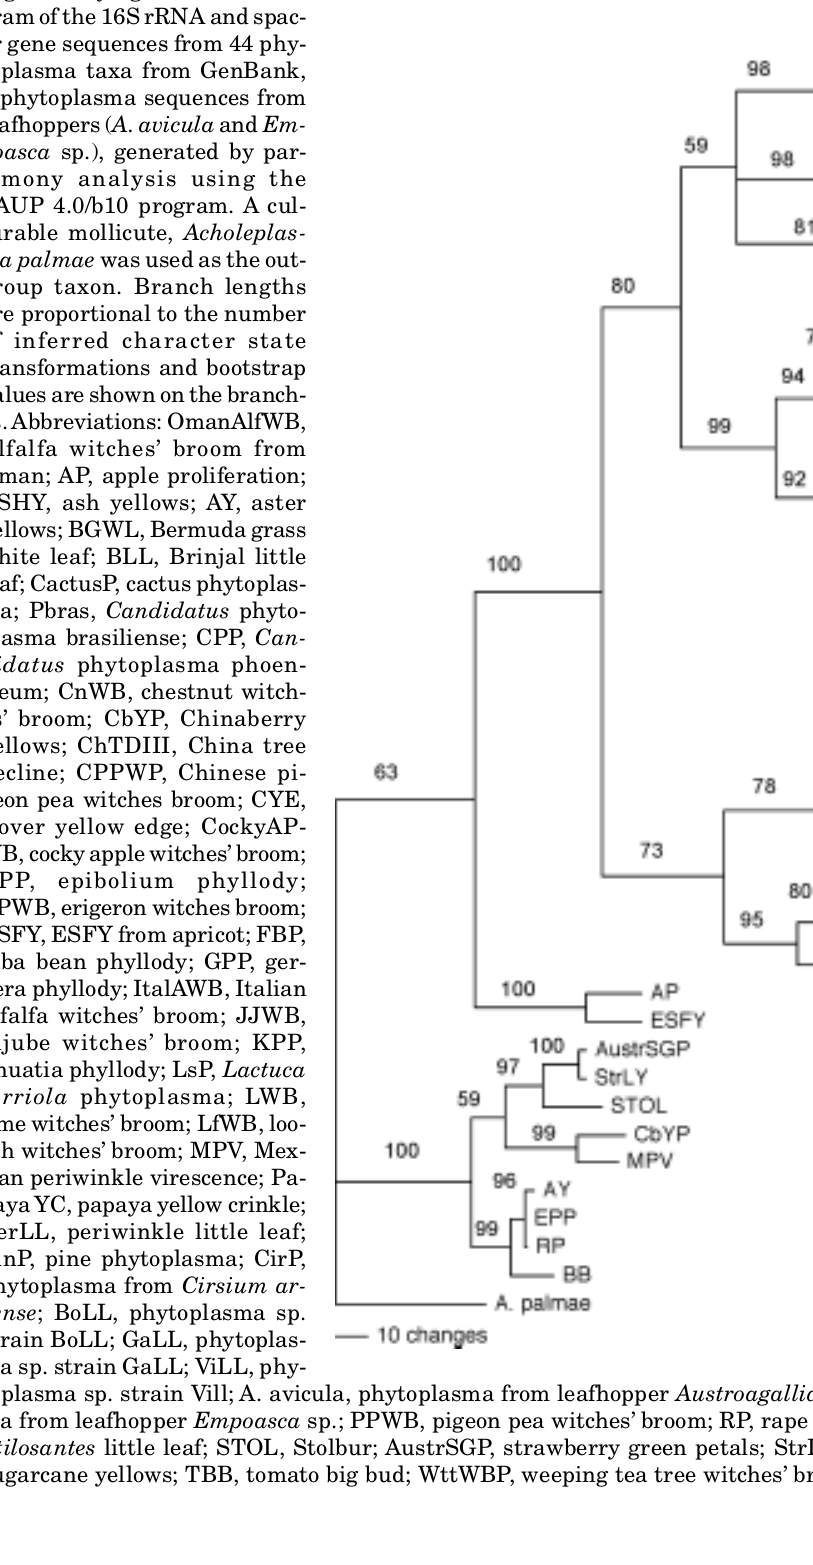
Fig. 4. Phylogenetic dendro- gram of the 16S rRNA and